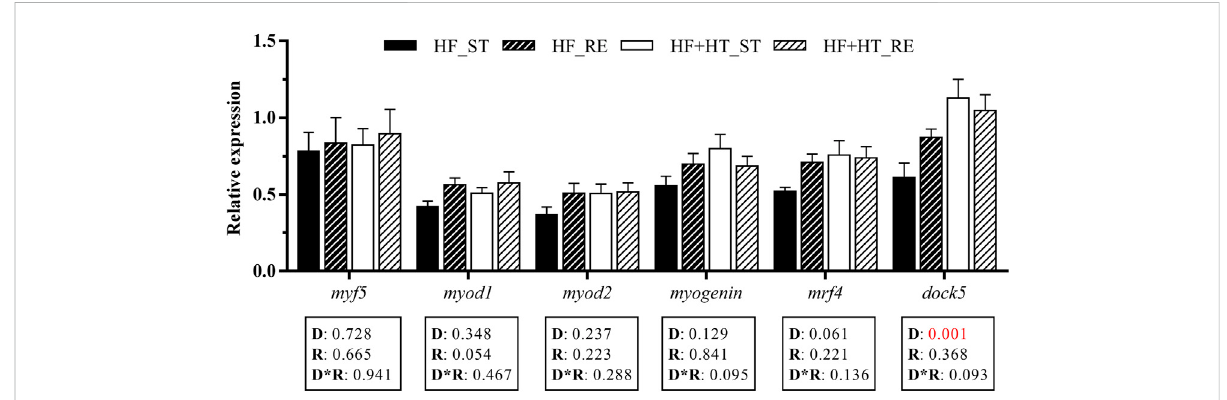
FIGURE 4 Relative gene expression of myogenic markers in white muscle of gilthead sea bream juveniles fed with a high-fat diet in the absence (HF) or presence (HF + HT) of hydroxytyrosol (0.52 g HT/kg feed), at a standard (ST) (3% biomass/tank) or restricted ration (RE) (40% daily reduction) for